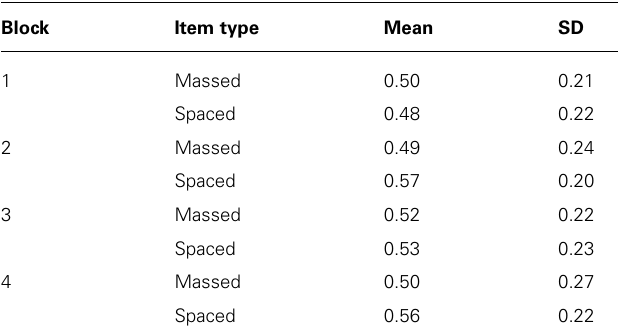
Table 2 | Mean proportion of false alarms (distractors incorrectly identified as old) on the final test and standard deviation as a function of block and item type.